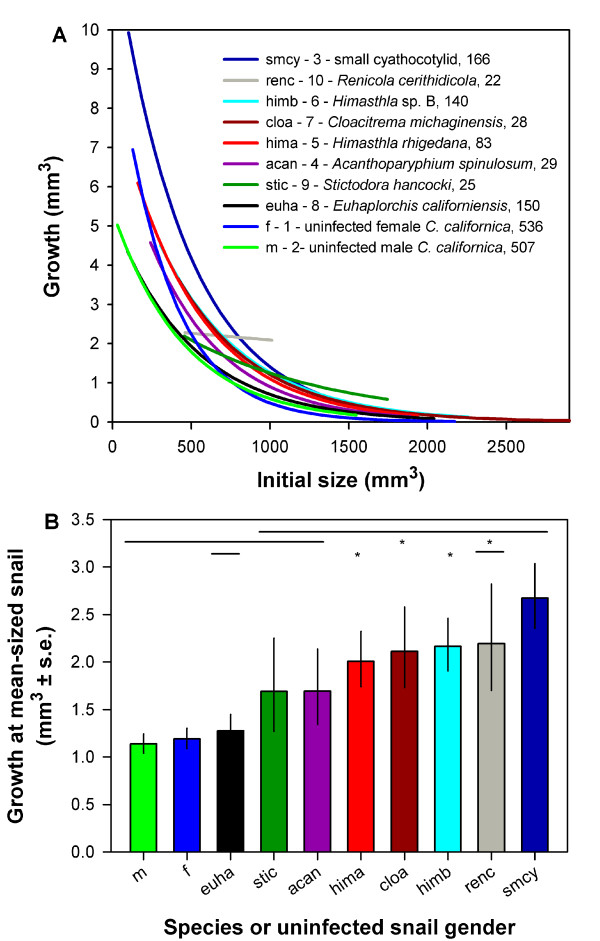
Variation in growth for eight different species of trematode parasitic castrators (operating stolen host bodies) and for both genders of uninfected horn snails. (A) Curves denote mean size-specific growth rates over the size-range sampled for each species (as estimated from a generalized linear model, Table 1). Species in legend are in the descending order of the growth curves as encountered at the mean-sized snail (705 mm3, or ~ 25.9 mm length), and sample sizes directly follow the species' names (Additional file 1, Table S1 lists the species' taxonomic families). (B) Variation in growth at the mean-sized snail. Results of pair-wise comparisons indicted. Bars sharing an equal-height line are not significantly different at the nominal P = 0.05 level. Asterisks denote additional non-significant differences when controlling for multiple comparisons by holding the False Discovery Rate to 0.05. Data in (A) and (B) represent 1,686 individuals spread throughout 17 sites in three southern California estuaries. Data standardized to reflect 3.5 months of growth in Carpinteria Salt Marsh channels. Other figures and the text use the species' letter and number codes.